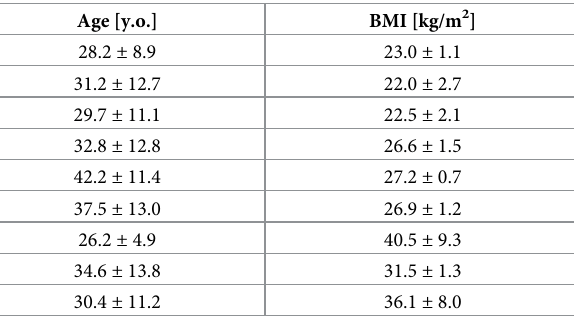
Table 2. Age and anthropometric data of participants. All the data are reported as mean ± standard deviation.